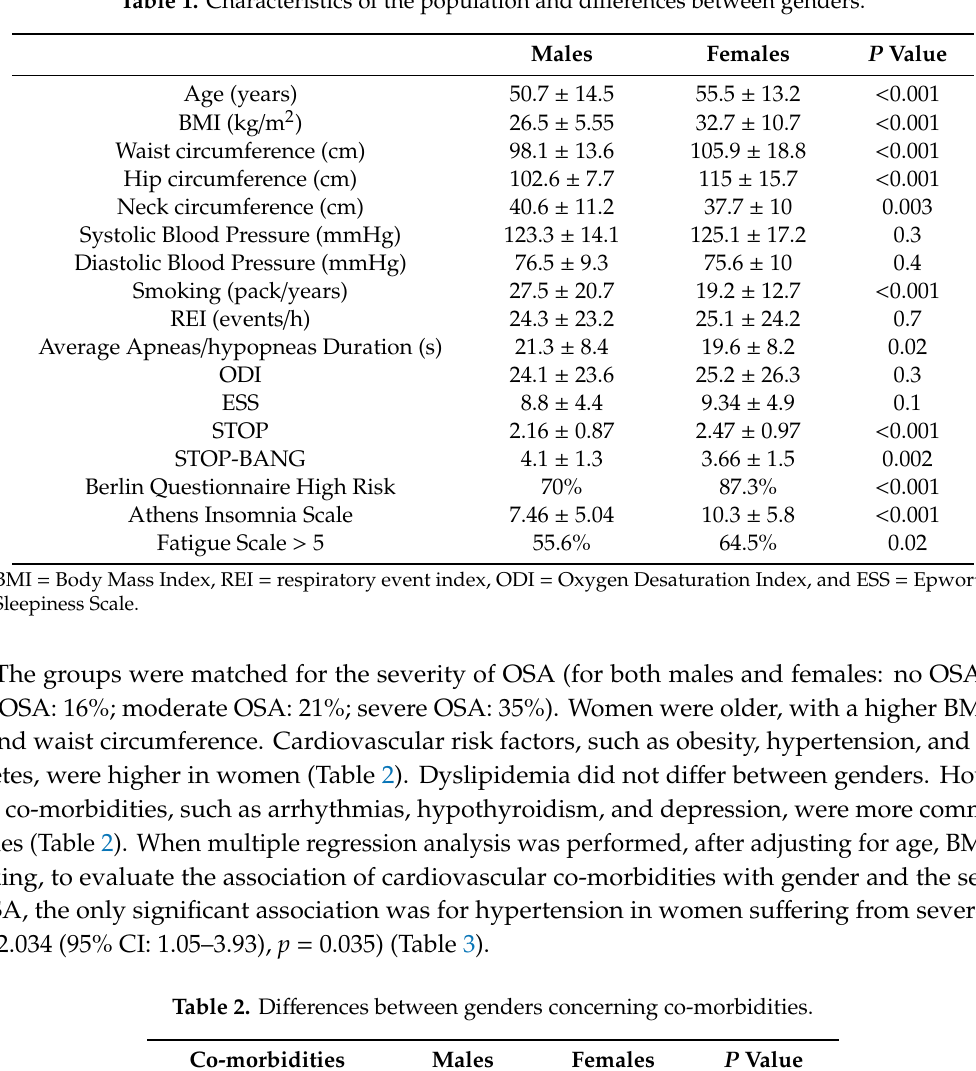
Table 1. Characteristics of the population and di ff erences between genders.